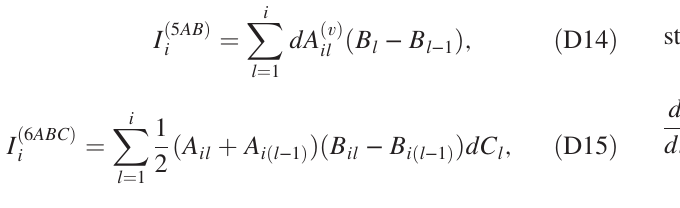
where the superscripts ( v ) and ( h ) represent the vertical ( t 0 ) and horizontal ( t ) derivatives in the discretized times; see Fig. 11 for an intuitive understanding.